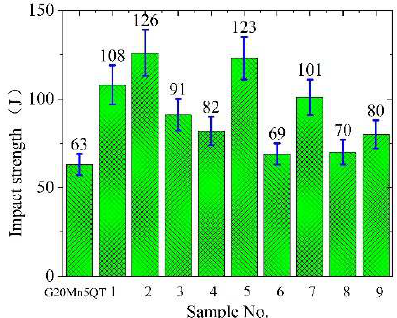
Figure 11. Low-temperature impact energy.